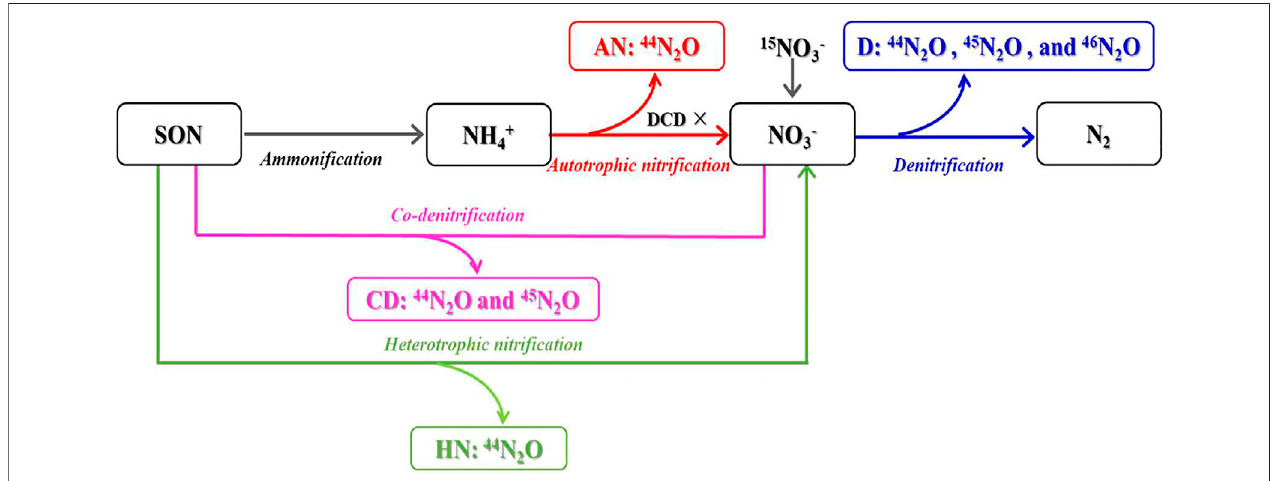
FIGURE 1 | Schematic diagram of N 2 O production via microbial processes quanti fi ed by the 15 N-NO 3 − labelling combined with nitri fi cation inhibitor (DCD) application. AN, HN, D, and CD represent autotrophic nitri fi cation, heterotrophic nitri fi cation, denitri fi cation, and co-denitri fi cation,